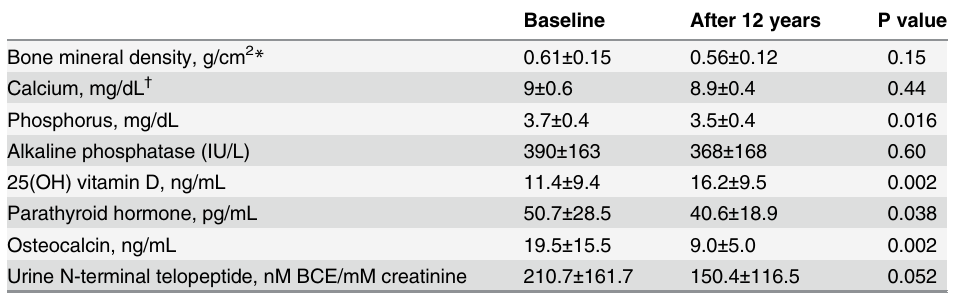
Table 5. Changes in bone metabolism markers during long bedridden